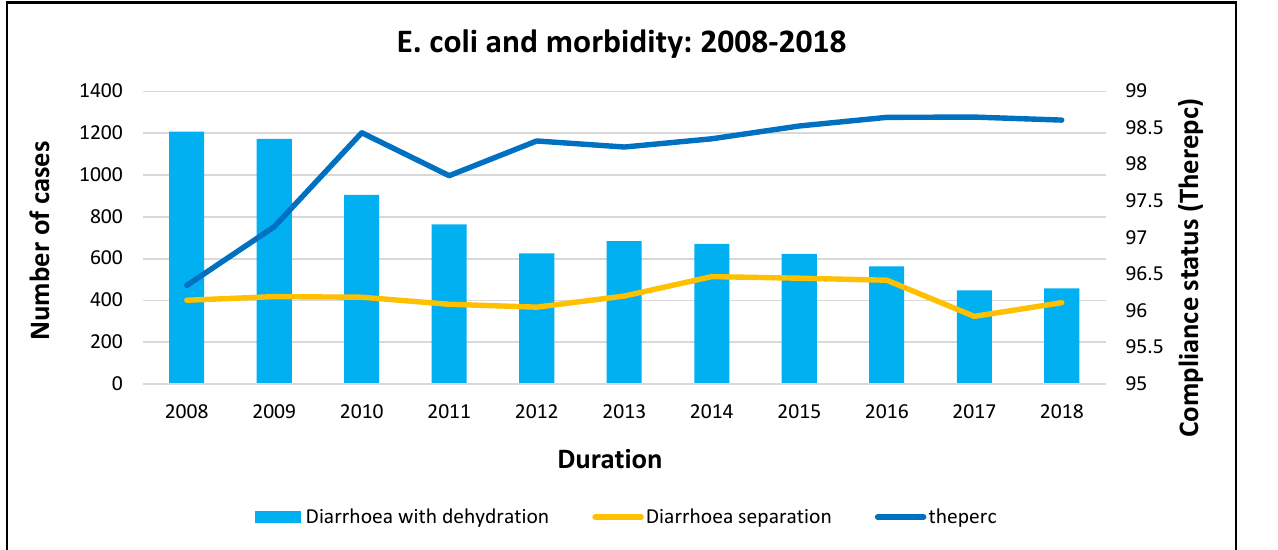
Figure 6. E. coli and mortality trends at the national level. Figure 7 indicates that E. coli pathogen compliance generally increased between 2008 and 2018. There was an exponential increase from 2008 to 2010, which coincided with a drastic drop in morbidity (diarrhoea with dehydration). Compliance dropped slightly in 2011, although this did not affect the decrease in morbidity, and compliance continued to increase until 2018, with morbidity also decreasing until 2018.